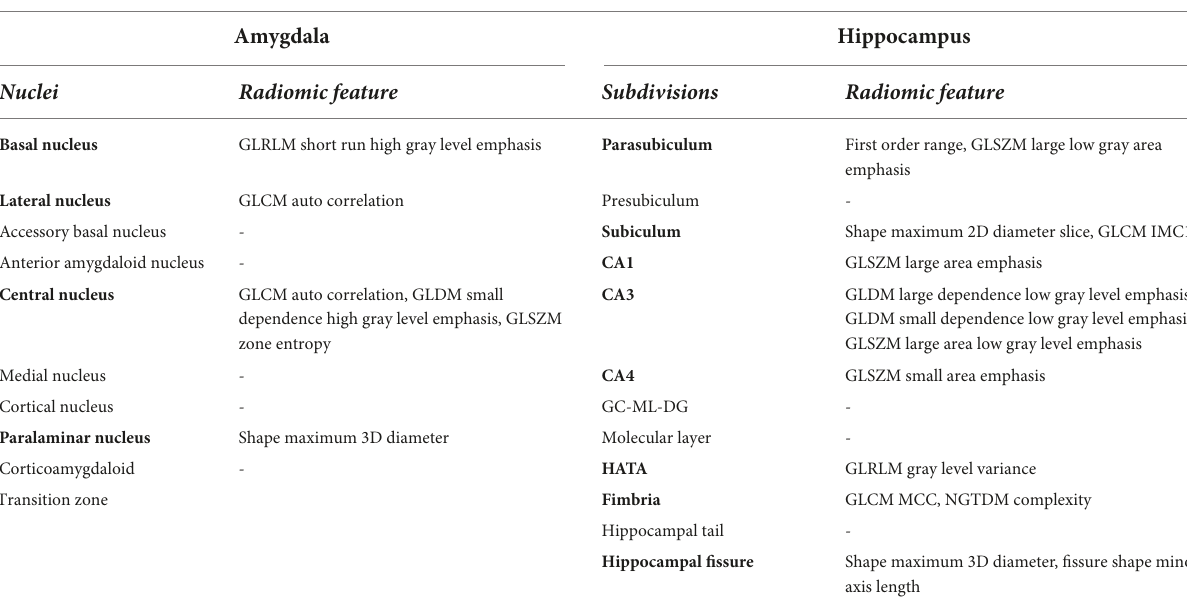
TABLE 2 Labeling of FreeSurfer’s amygdalar-hippocampal segmentation output and nuclei with selected radiomic features used to predict STN-DBS motor